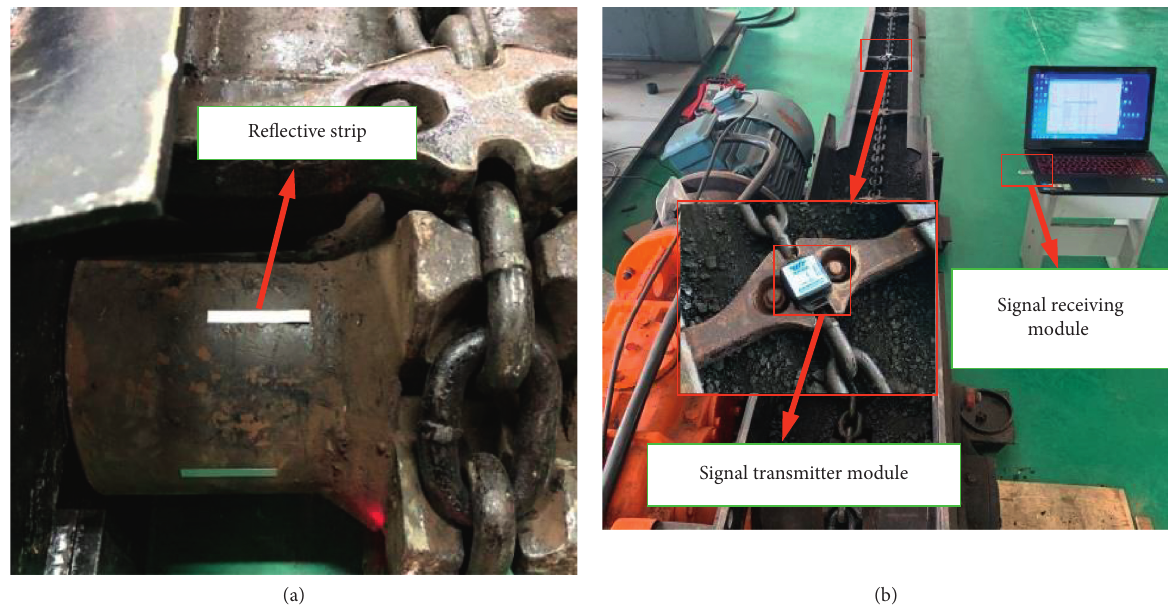
Figure 1: Sensor installation position. (a) Installation of the laser reflector. (b) Bwt901cl Bluetooth sensor